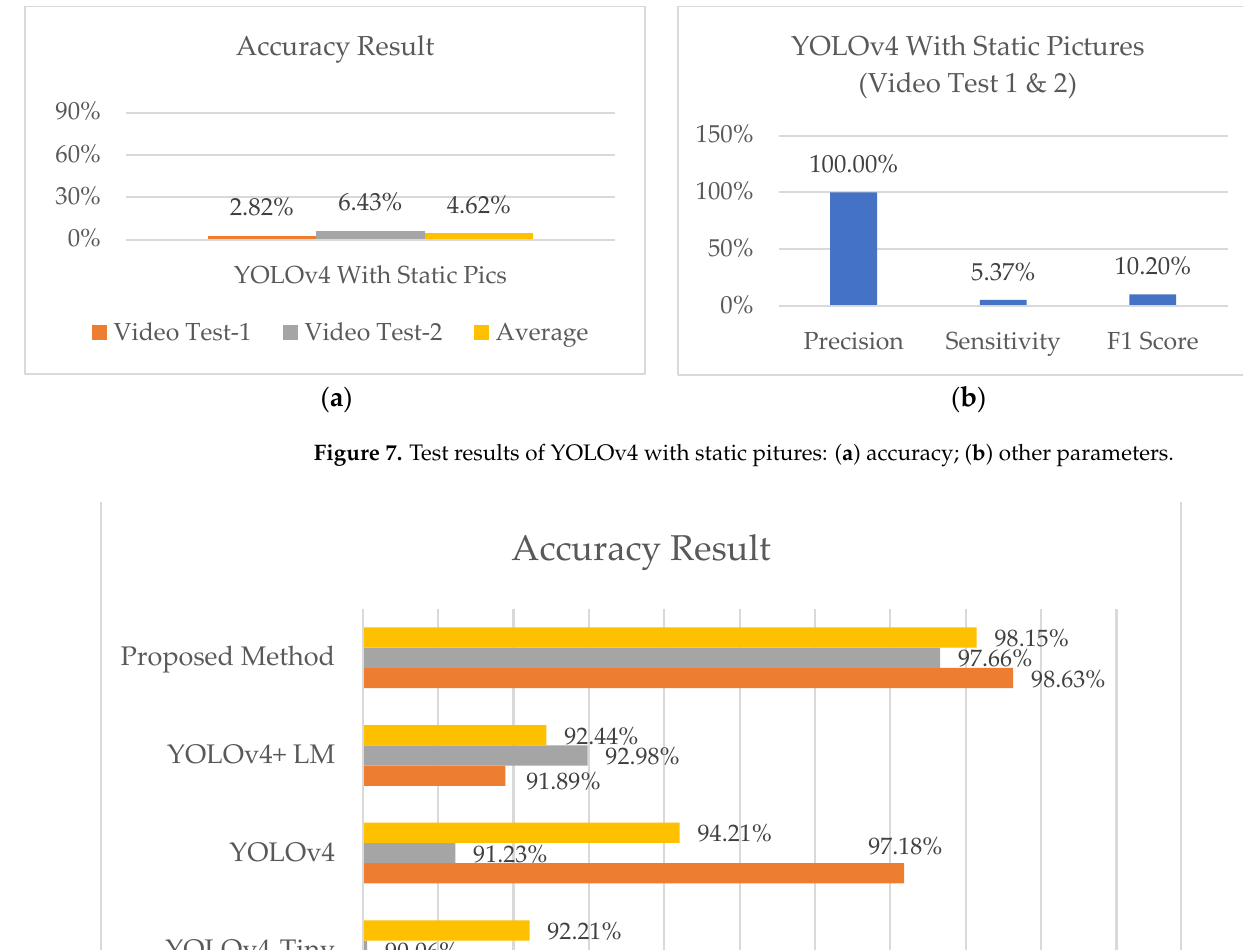
Figure 8. Experimental results (accuracy).